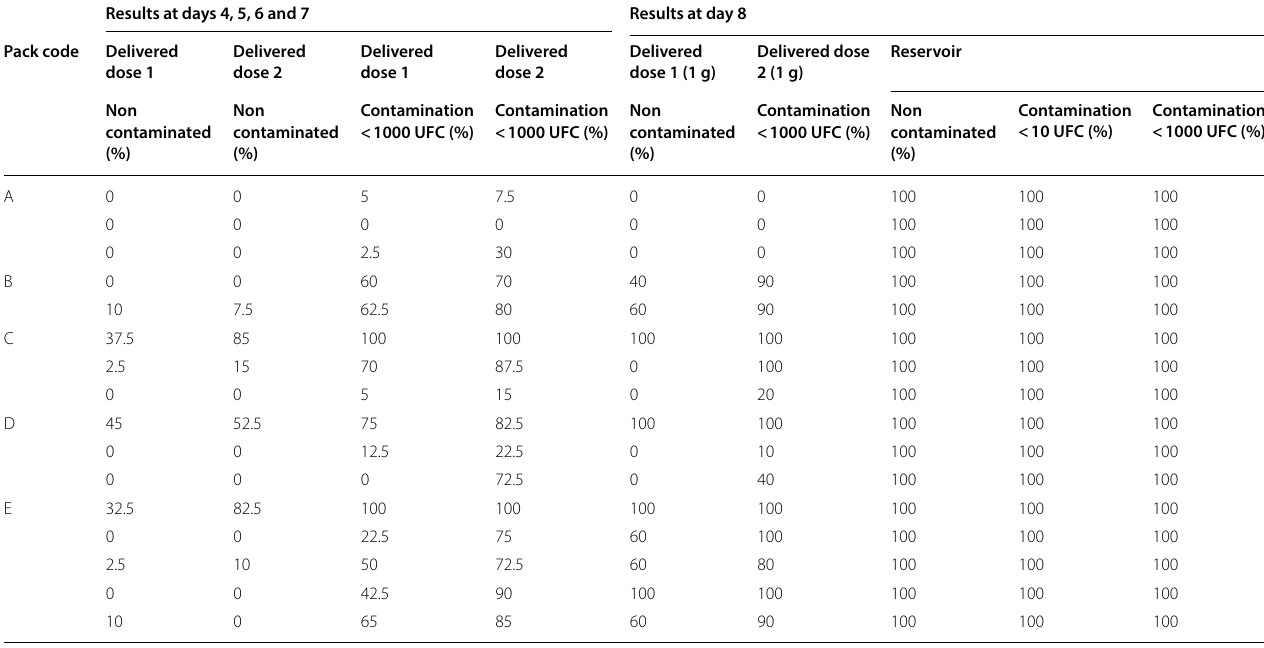
Table 3 Results from in-use